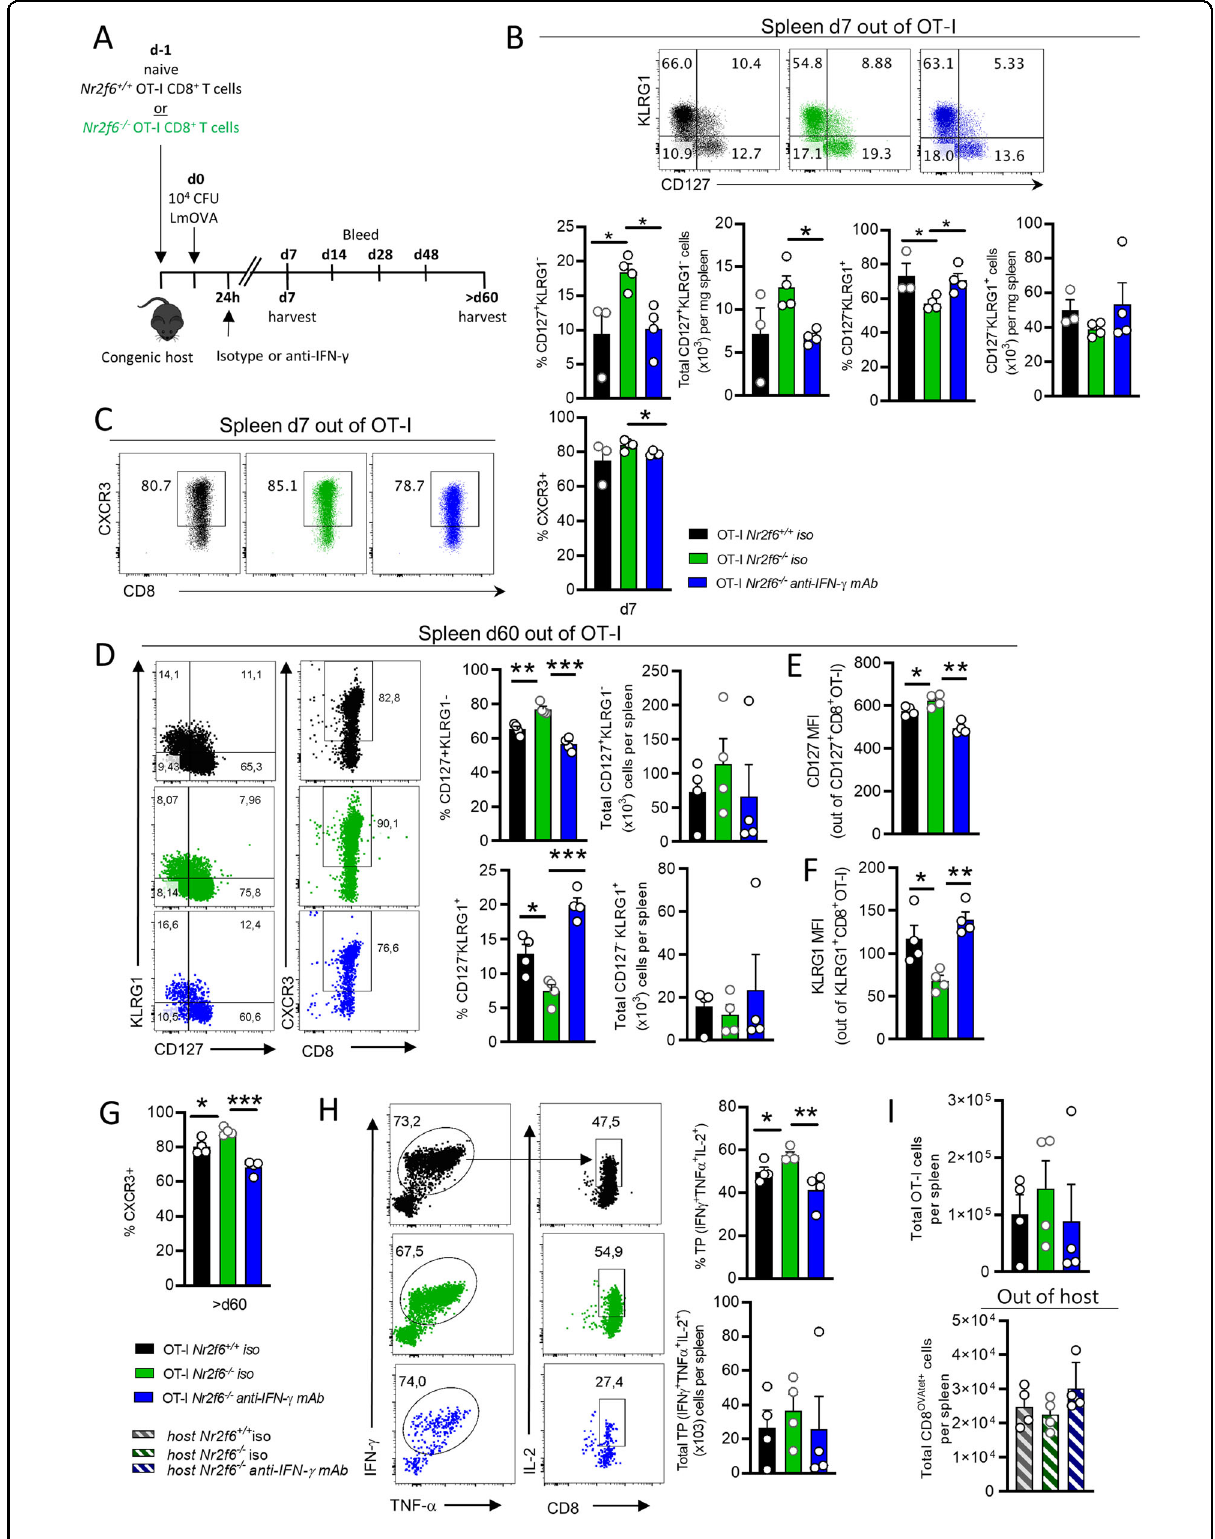
Fig. 6 (See legend on next